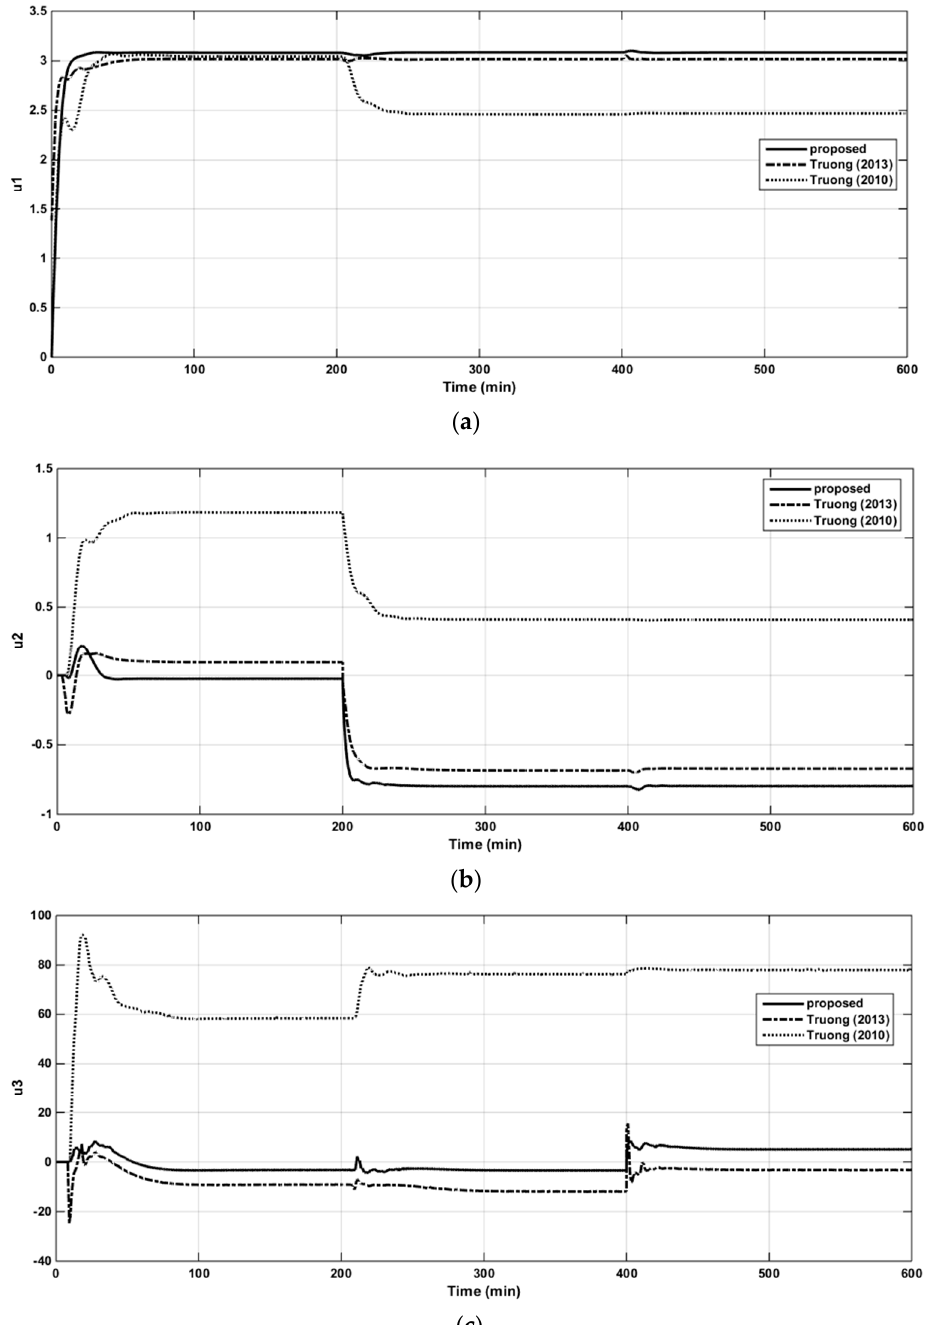
Figure 22. The control signal in loop 1 of the OR column ( a ). The control signal in loop 2 of the OR